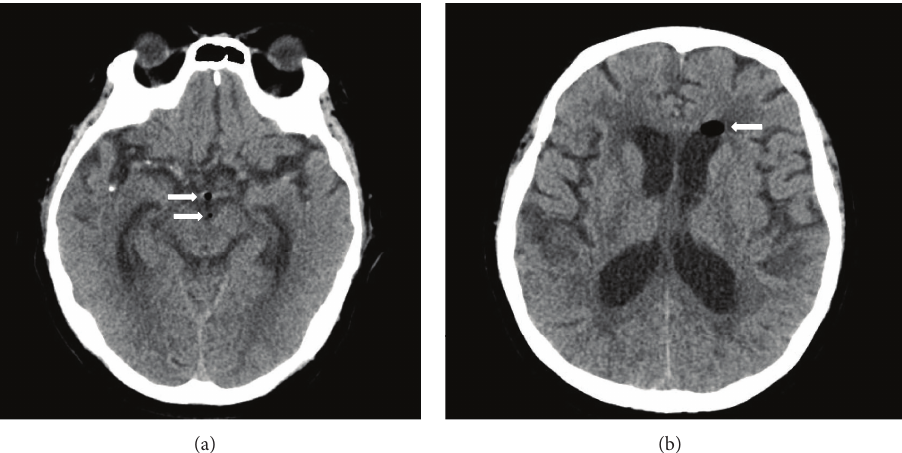
Figure 1: Axial computed tomography (CT) scan of head demonstrated free air (arrows) in the left lateral ventricle frontal horn and basal